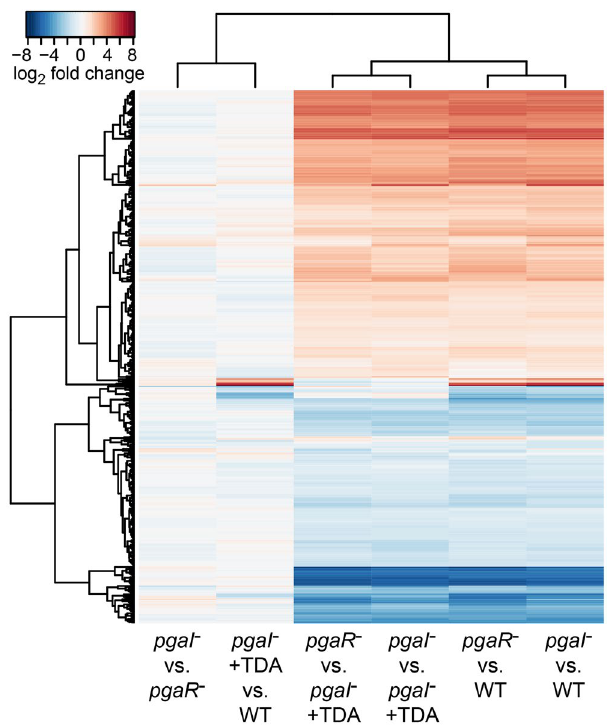
Figure 1. Hierarchical clustering based on gene expression patterns of WT and mutants of P. inhibens analysed by whole transcriptome microarrays. In each column two transcriptomes are compared. “ + TDA” indicates addition of subinhitory amounts of TDA to the culture (Methods). Identical genes are at the same height in each column and clustered in height based expression fold changes. Red indicates upregulated, blue downregulated gene expression of the upper strain with respect to the lower strain listed below the respective column. Dendrograms are based on euclidean distances and provide a measure of relatedness, at the left side for clustered differentially expressed genes and at the top for the different microarrays. Minor differences between the two microarrays “ pgaI − vs. WT” and “ pgaR − vs. WT” are largely based on statistical calculations including cut-off values (absolute value of fold change ≥ 1, p -value <